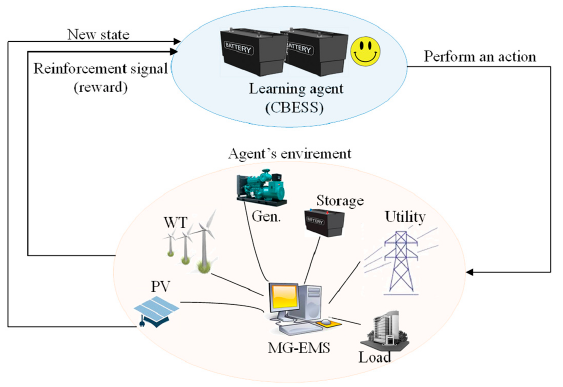
Figure 2. Q-learning principle diagram.